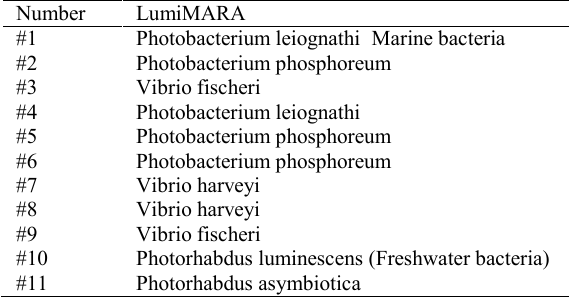
bioluminescent bacteria strains